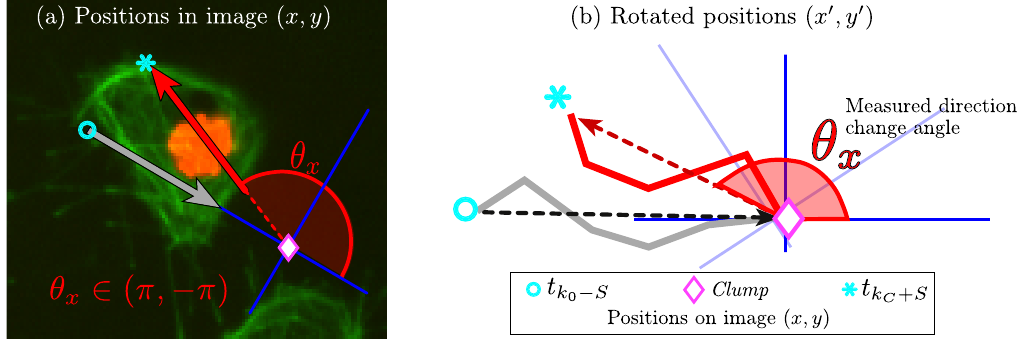
Figure 9. Illustration of direction change ( θ x ) measurement. Three markers represent different positions of a given track. The markers are as follows: ( ◦ ) represents S frames before contact; ( (cid:5) ) represents the starting instant of the clump; and ( ∗ ) represents the position where the experiment is finalised. Notice the translation and rotation into the new frame of reference ( x (cid:48) , y (cid:48) )